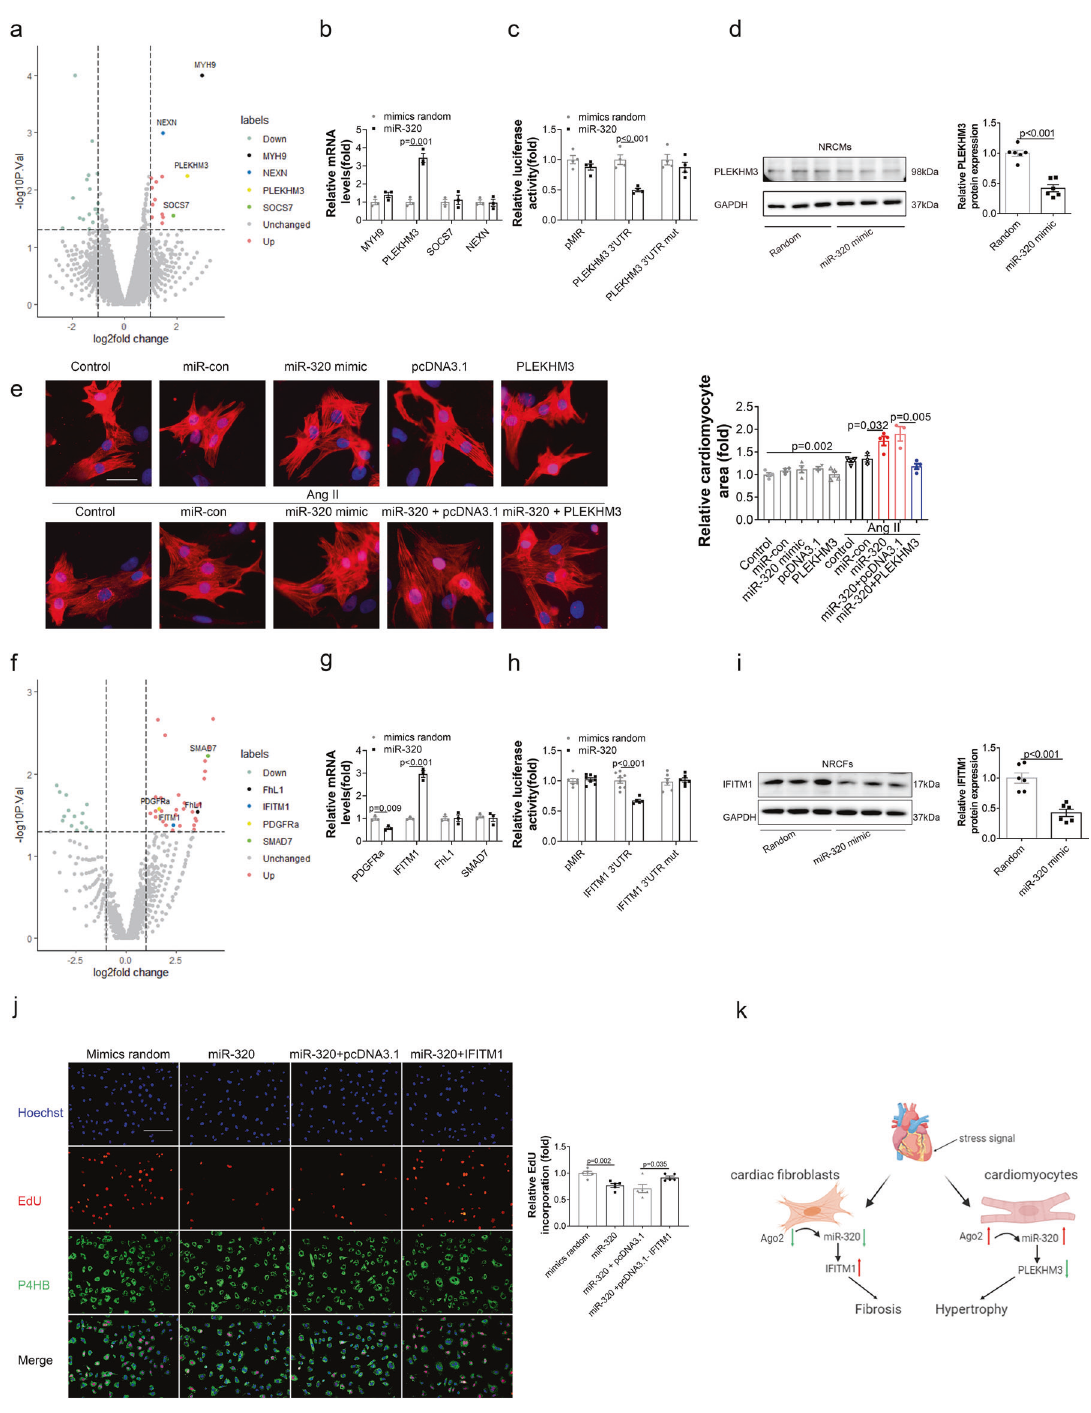
Fig. 6 MiR-320 targeted different signals in CMs and CFs. a Volcano plot of RIP-seq in H9c2 cells. b The levels of mRNA in miR-320-transfected NRCMs detected by RNA binding protein immunoprecipitation ( n ≥ 3). c Regulation of miR-320 on the 3 ′ -UTR of plekhm3 detected by luciferase reporter assays in HEK293 cells. d The protein levels of plekhm3 in NRCMs with different treatments were detected by western blot (left), quanti fi ed by Image J (right; n = 6). e Representative images of CMs areas stained by ACTN2 (left), and quantitative analysis of cell sizes (right). Scale bar, 100 µm. f Volcano plot of RIP-seq in NRCFs. g The levels of mRNA in miR-320-transfected NRCFs detected by RNA binding protein immunoprecipitation ( n ≥ 3). h Regulation of miR-320 on the 3 ′ -UTR of IFITM1 detected by luciferase reporter assays in HEK293T cells ( n ≥ 3). i The protein level of IFITM1 in NRCFs with different treatments detected by western blot (left), quanti fi ed by Image J (right; n = 6). j Representative images of immuno fl uorescence staining for EdU (red), Hoechst (blue), and P4HB (green) in NRCFs with different treatments (left). Scale bar, 100 µm. Quantitative analysis of EdU measured by Image J (right). k A model to illustrate the roles of miR-320 in CFs and CMs during HF. Data are expressed as mean ± SEM